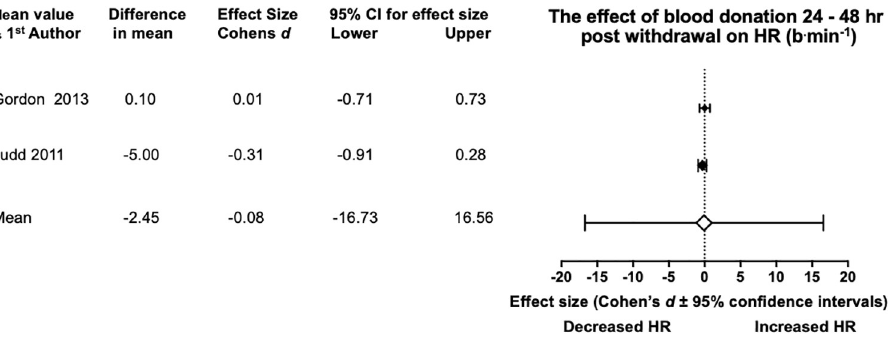
Fig 3. Statistical results from two studies of pre and 24–48 hr post BD in HRmax. With the diamonds reflecting the effect size of the studies. The white diamond shows the overall mean effect size. All effect sizes are Cohen’s d and 95% confidence interval, with heterogeneity of I 2 =